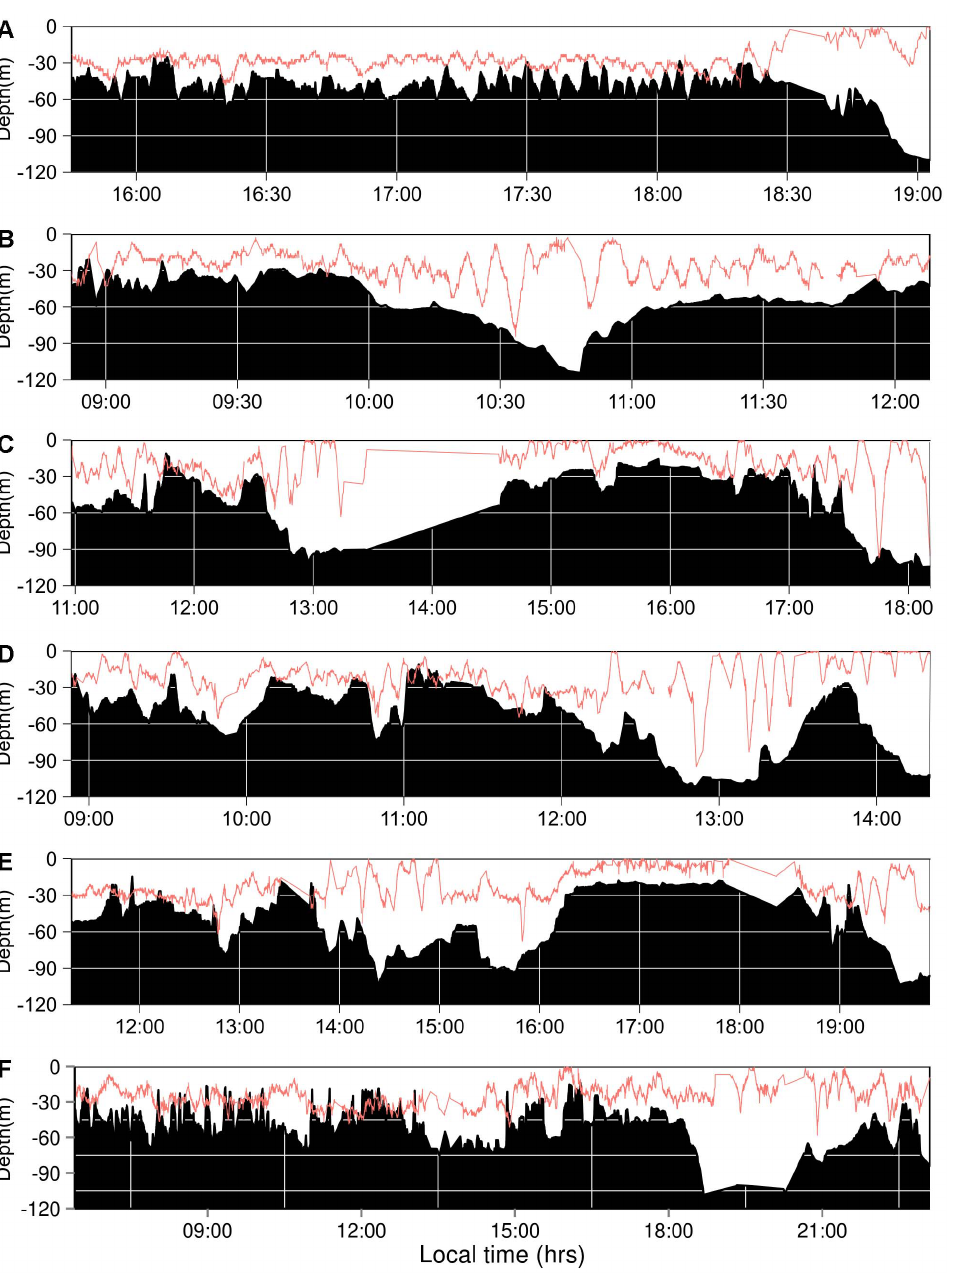
Fig. 7. Whale sharks dive profiles at Darwin Island. Plots showing dive profile and bottom depth of RT-01 (A), RT-02 (B), RT-03 (C: Nov 14 th , and D: Nov 15 th , the latter only showing her dive profile during the time she remained in the vicinity of the island ( , 1.3 nm)) and RT-04 (E: Nov 16 th , and F: Nov 17 th ), respectively. Signal from RT-03 was lost from 13:33 PM to 14:32 PM on Nov 14 th (C). Note that bottom depth contour was obtained from skiff position, so sharks dive’s and bottom depth’s profiles relationship may not coincide exactly with the reality. For this reason shark dive profiles overlap with bottom depth in few occasions, especially at shallow areas ( , 30